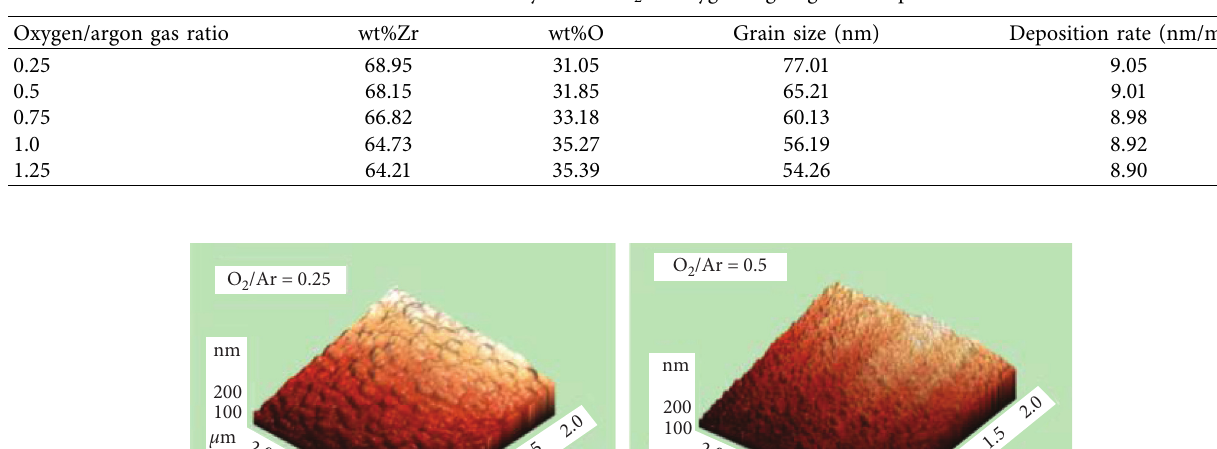
Table 2: Elemental analysis of ZrO